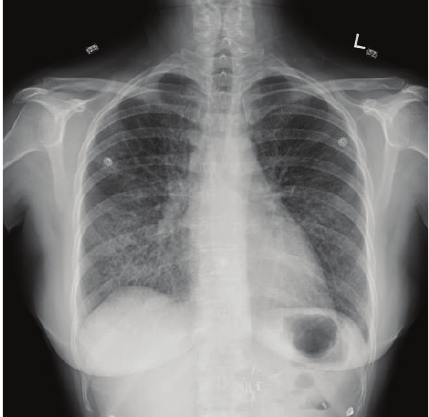
Figure 6: Posterior-anterior chest radiograph after three sessions of WLL, demonstrating improvement of the infiltrative process.